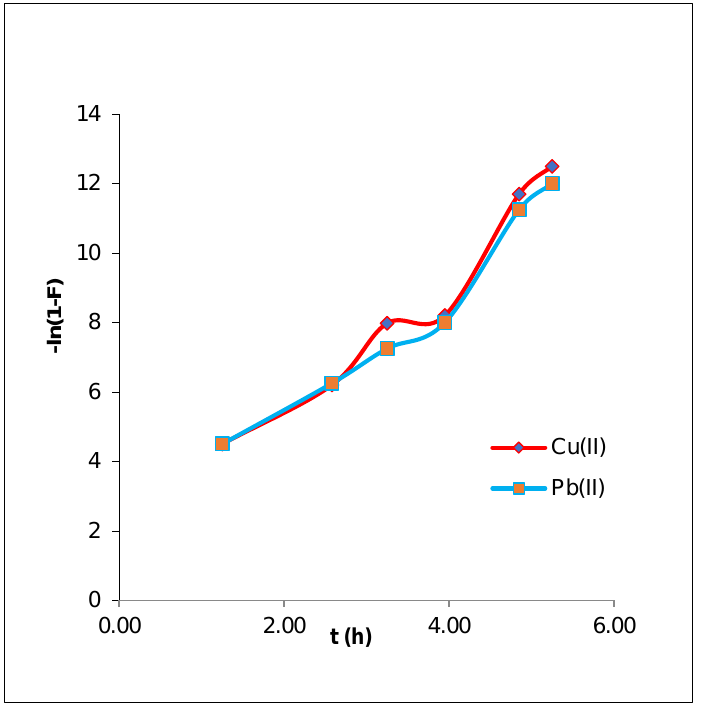
Figure 11. Liquid film diffusion model plots for the adsorption of CMOISW-based composites.